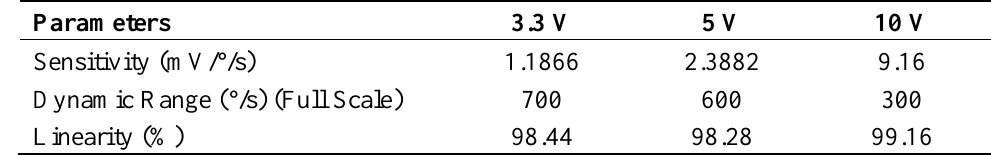
Table 5. Specification of the out-of-plane gyroscope.